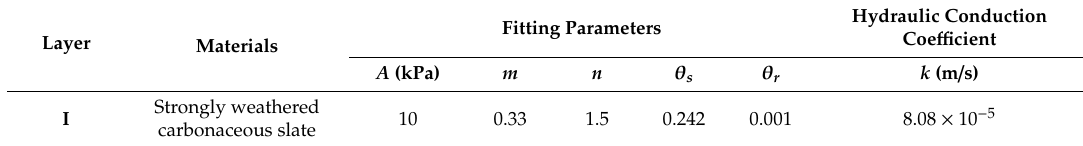
Table 1. Parameters of the water retention curve.